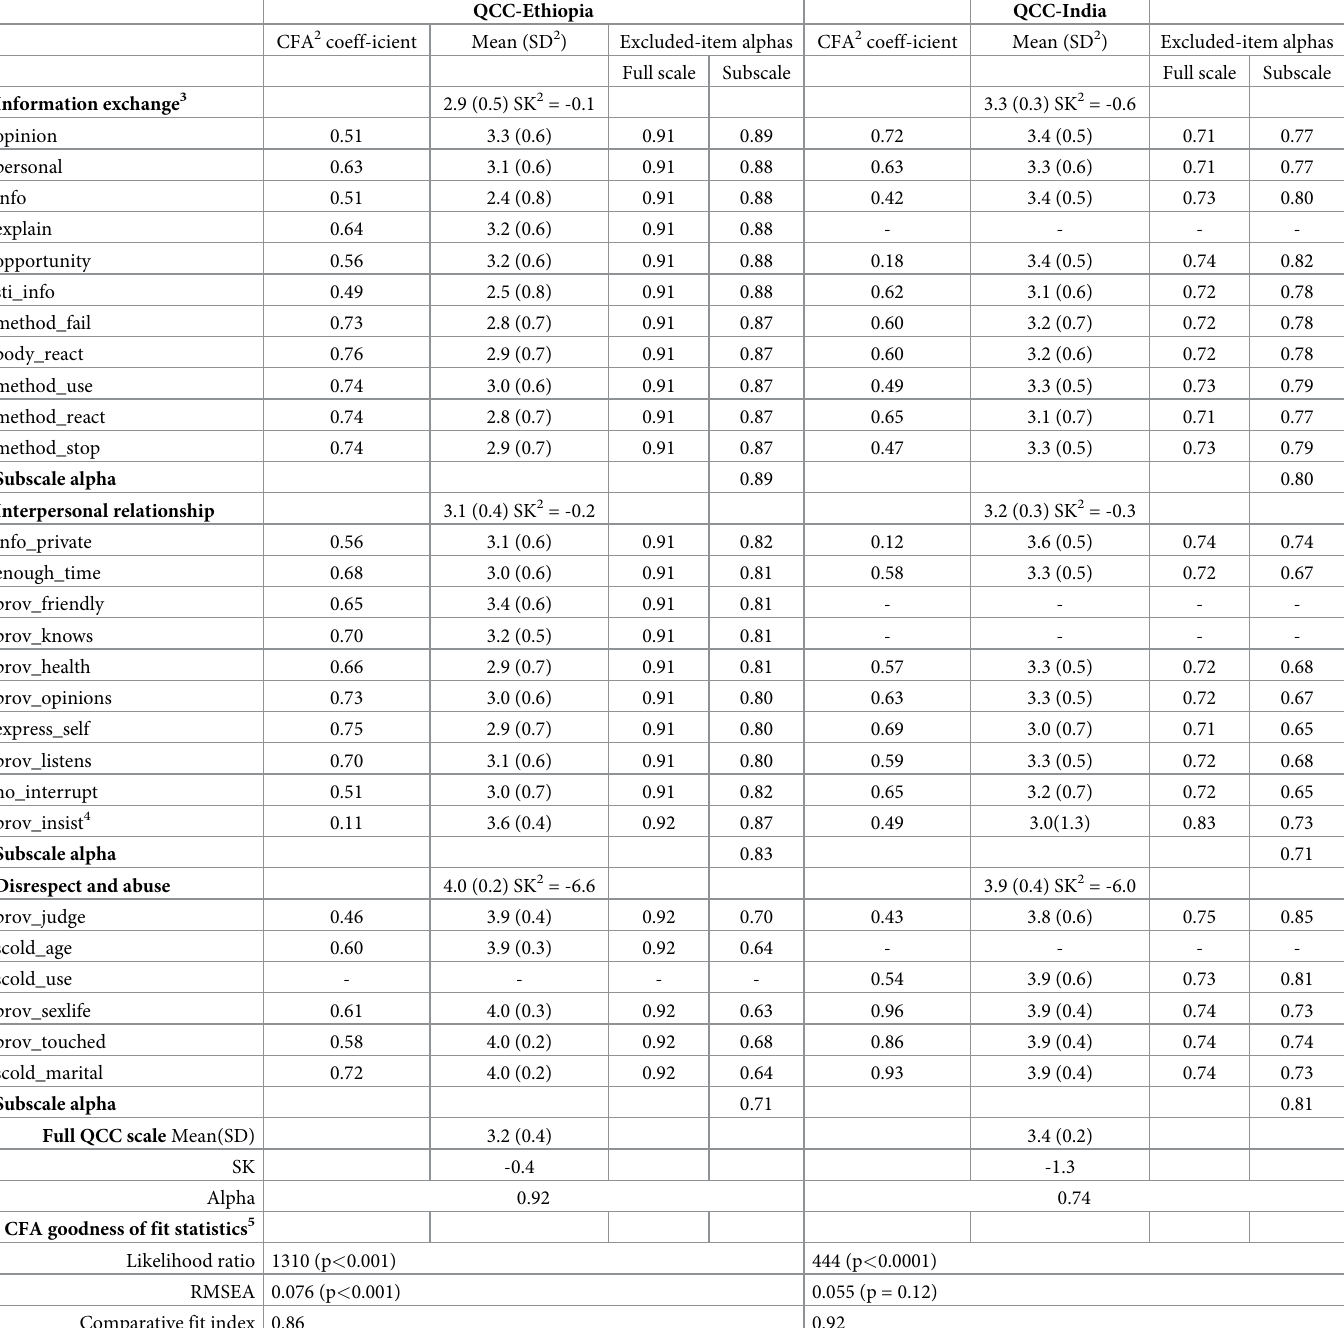
Table 3. Psychometric analysis results for the Quality of Contraceptive Counseling (QCC) scale from Ethiopia (QCC-Ethiopia; N = 599) and India (QCC-India; N = 313) 1